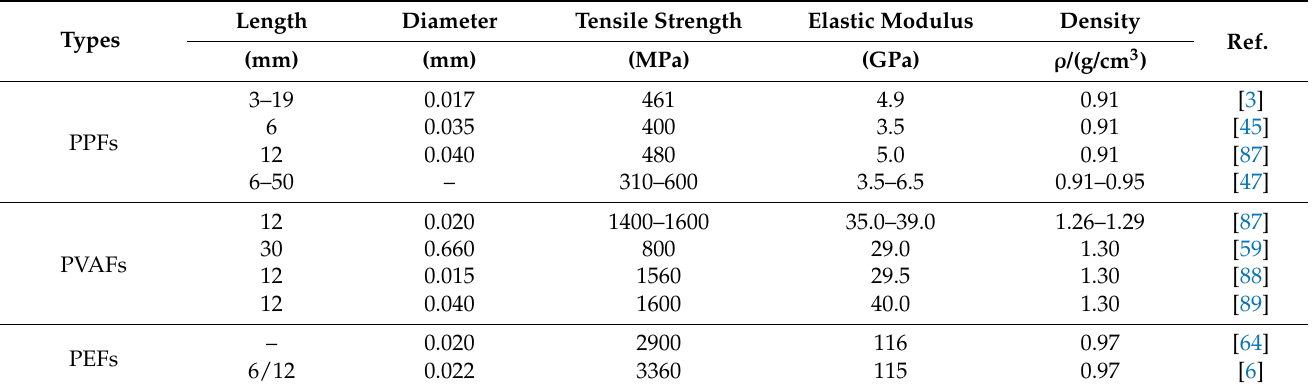
Table 4. Basic mechanical properties of typical synthetic